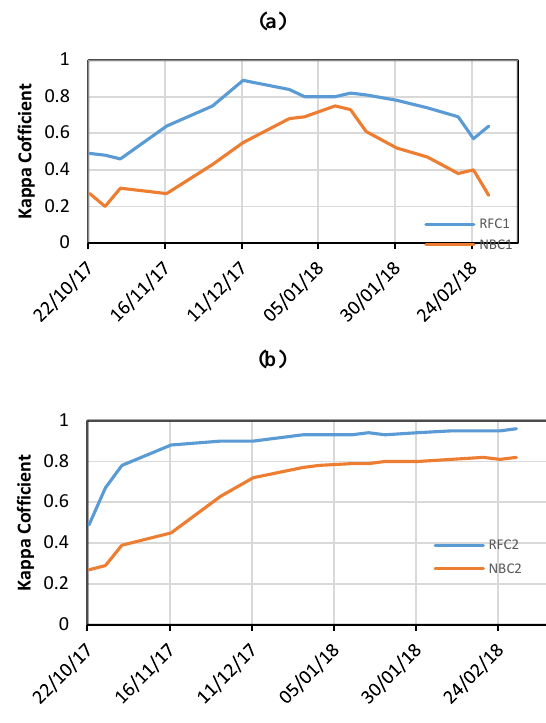
Figure 6: (a) Performance of RF and NB while using single day satellite data for model building, (b) Performance of RF and NB while using temporal data for model building.